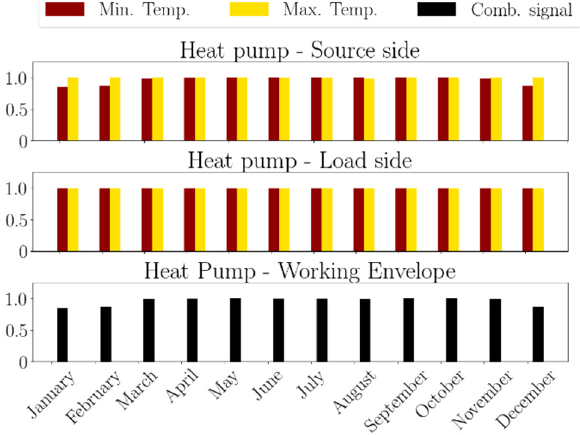
Figure 13. Monthly working envelope control signals of the heat pump.